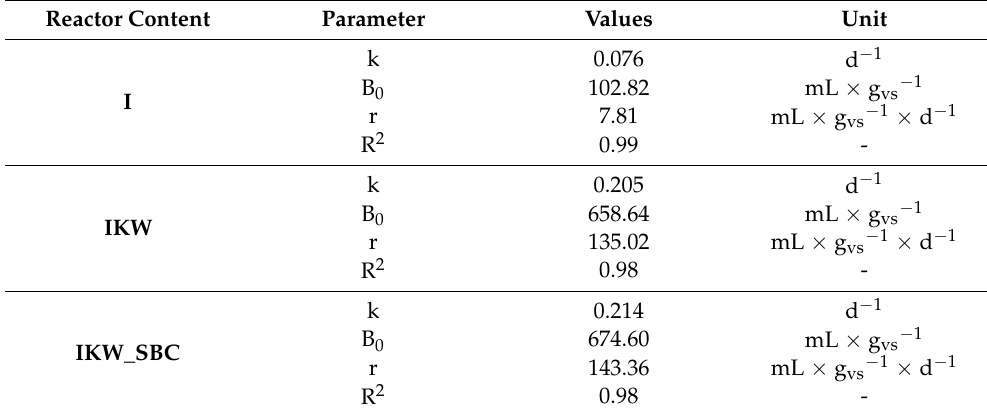
Table 2. Kinetic parameters of